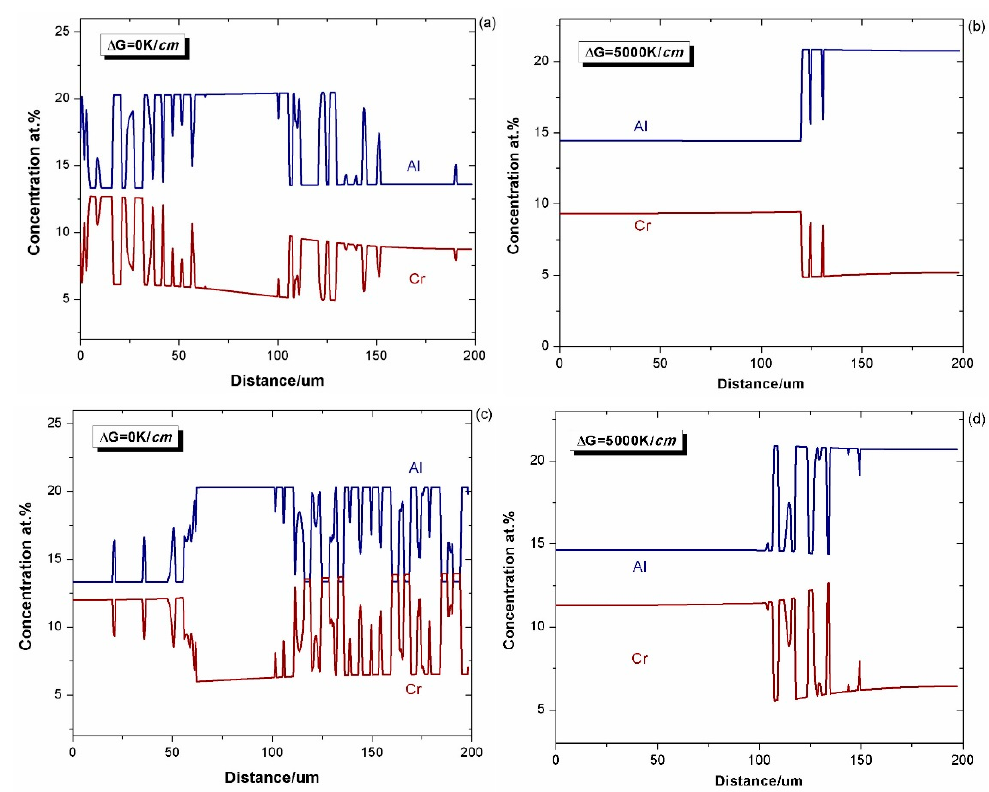
Figure 10. Composition distribution of Al and Cr in No. 7 γ + γ '/ γ + γ ' bond coat/substrate system (Ni–18at.%Al–12at.%Cr/Ni–16at.%Al–5at.%Cr) annealed ( a ) at 1373 K and ( b ) with an effect of temperature gradient Δ G = 5000 K/cm at 790,000 s; Composition distribution of Al and Cr in No. 8 γ + γ '/ γ + γ ' bond coat/substrate system (Ni–16at.%Al–5at.%Cr/Ni–18at.%Al–12at.%Cr) annealed ( c ) at 1373 K and ( d ) with an effect of temperature gradient ∆ G = 5000 K/cm at 600,000